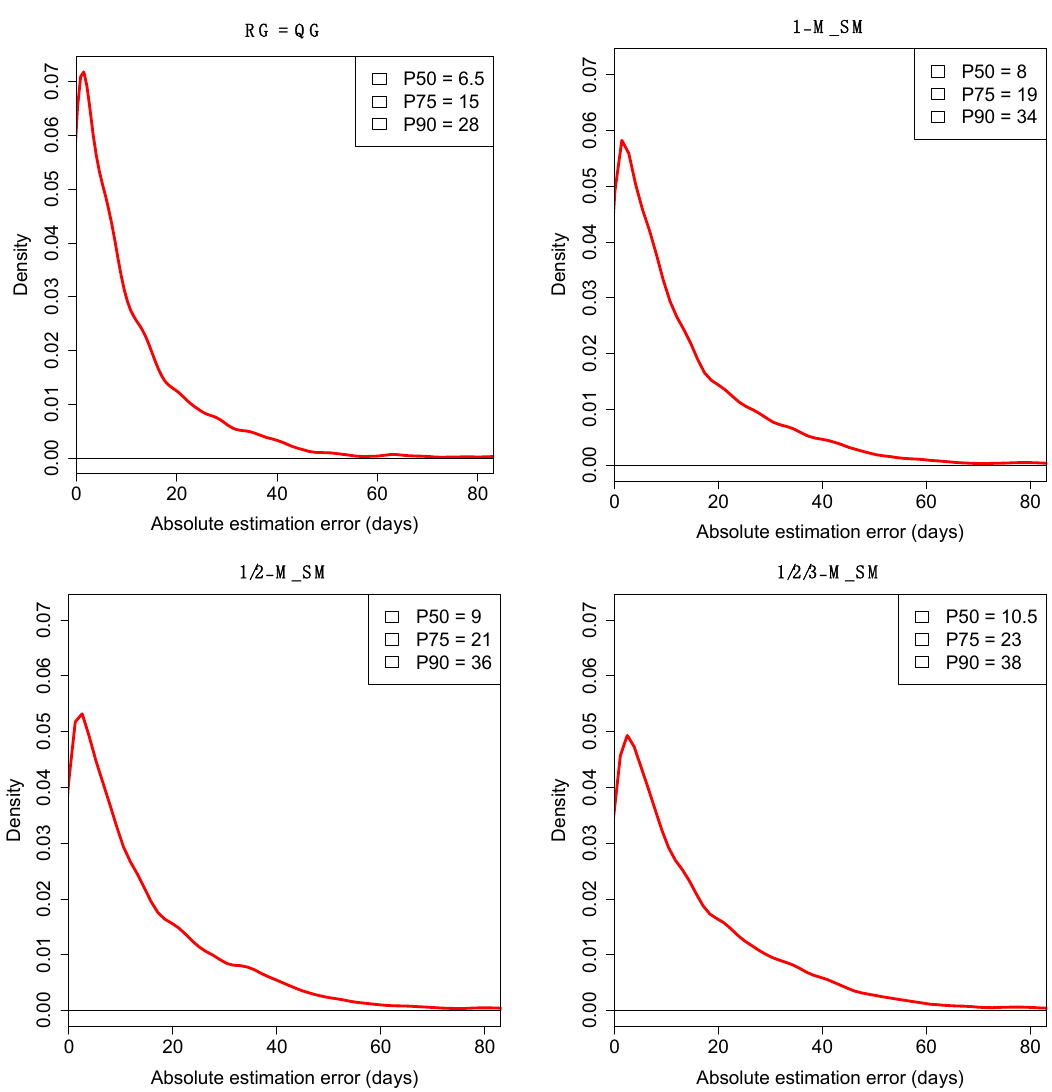
Figure 5. Errors (in absolute values) associated to the t E-QG estimates under different simulation mod- els. 1-M_SM = RG match or is a 1-step mutational ancestral or derivative from QG, 1/2-M_SM = RG match or is a 1 or 2-step mutational ancestral or derivative from QG; 1/2/3-M_SM = RG match or is a 1, 2 or 3-step mutational ancestral or derivative from QG; P50 = percentile 50; P75 = percentile 75, P90 = percentile 90.